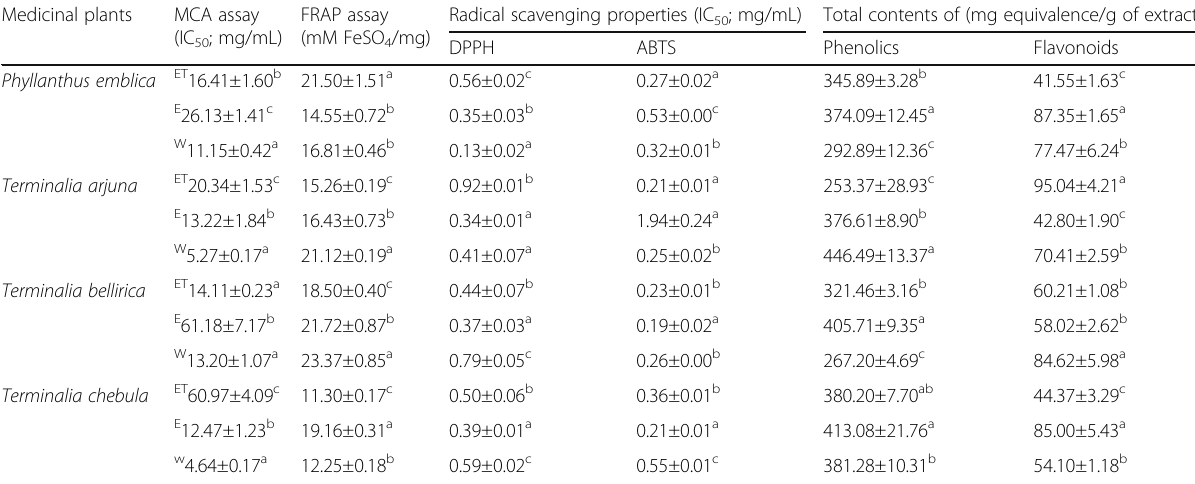
Table 4 Metal chelating activity (MCA), ferric reducing-antioxidant power (FRAP), free radical scavenging capacities, total phenolic content, and total flavonoid content of different extracts of Phyllanthus emblica , Terminalia arjuna , Terminalia bellirica , and Terminalia